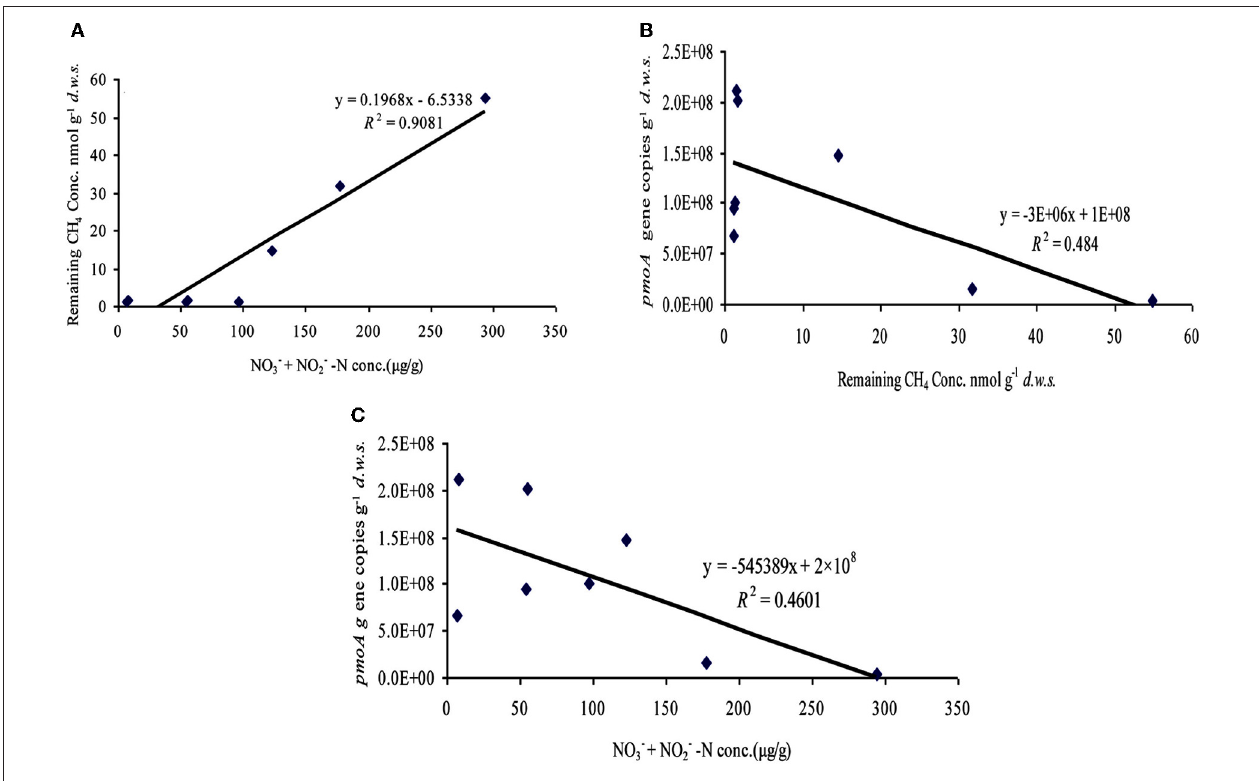
urea and ammonium sulfate after 27 days of incubation. The black line is the linear regression line between two parameters. The P values for panel (A) 0.001, (B) 0.055, and (C)